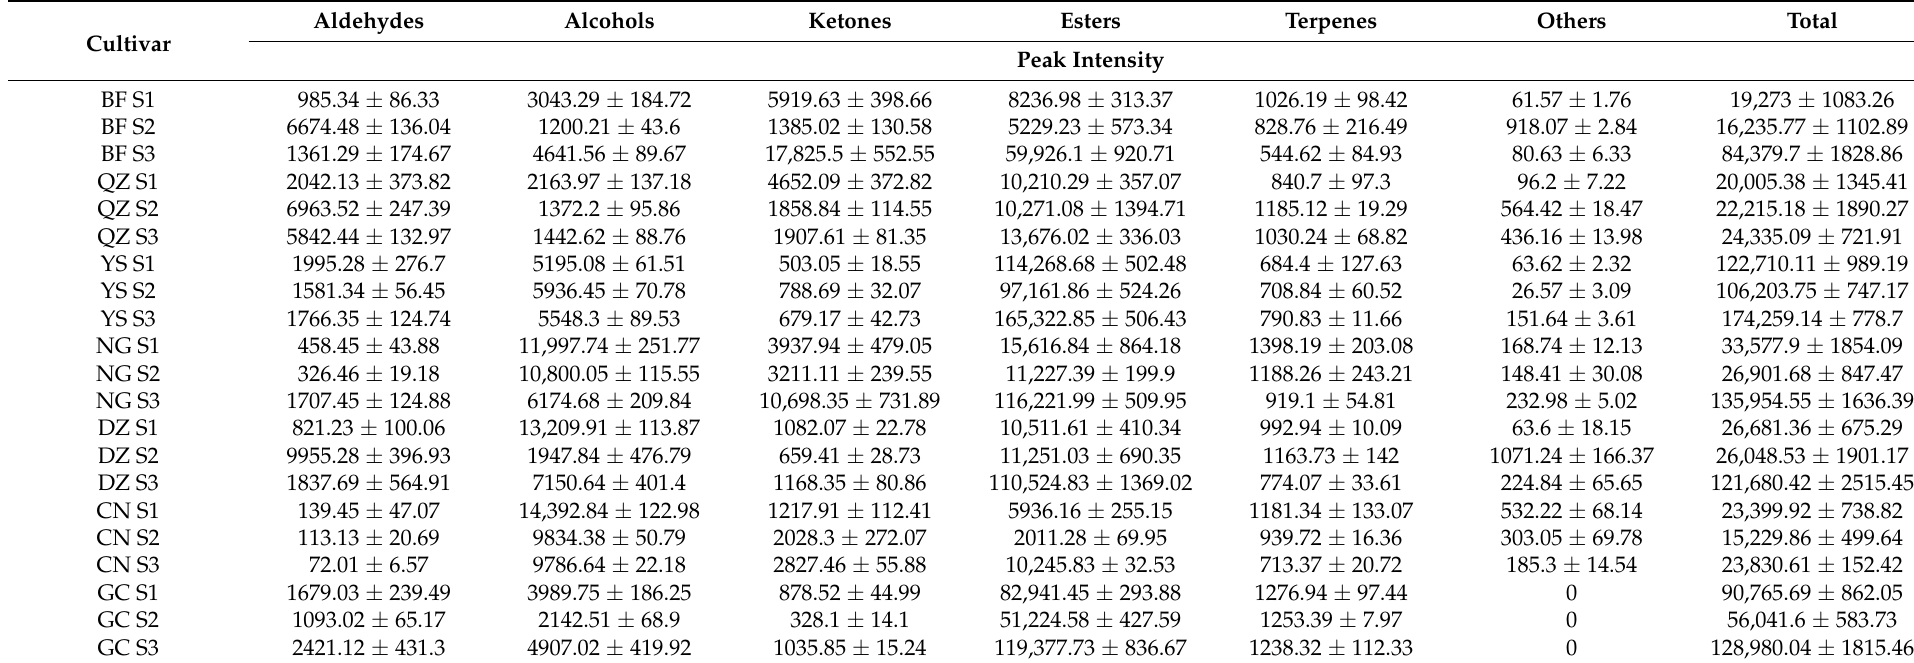
Table 2. Peak intensities and relative contents of volatile substances in different green plum samples during